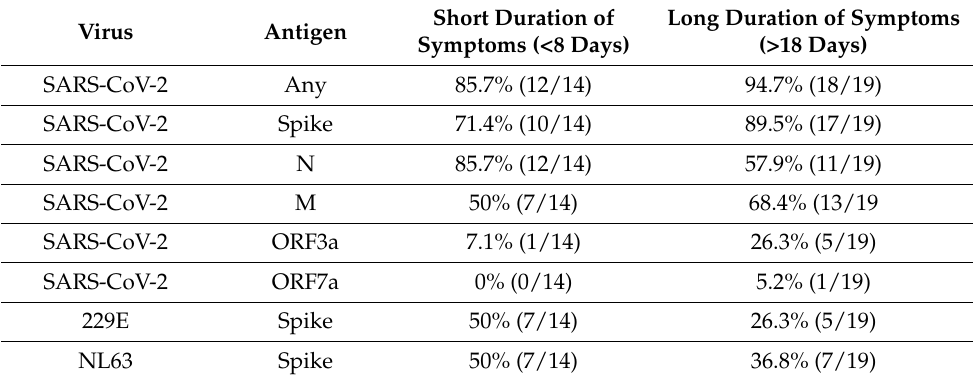
Table 2. Patterns of SARS-CoV-2 reactivity in convalescent COVID-19 patients.